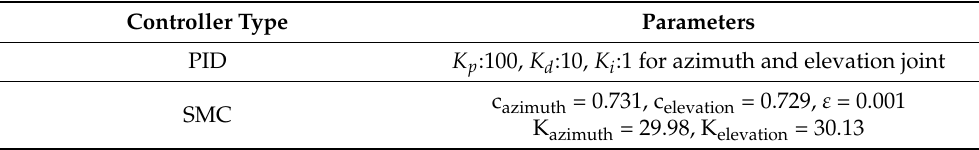
Table 5. Controller parameters of 2 DoF Turret.